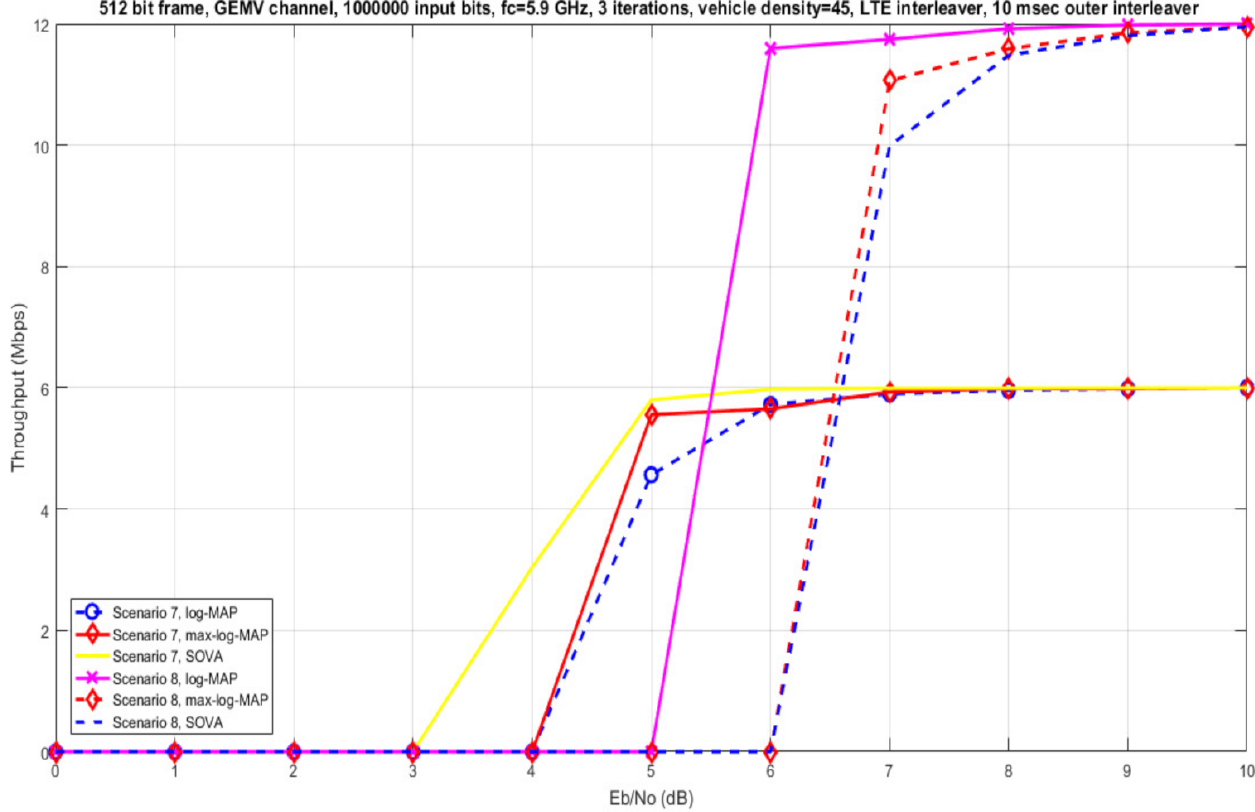
Figure 12. Throughput vs. SNR for scenarios 7 and 8 of Table 2, considering different decoding algorithms, 3 iterations, frame length of 512